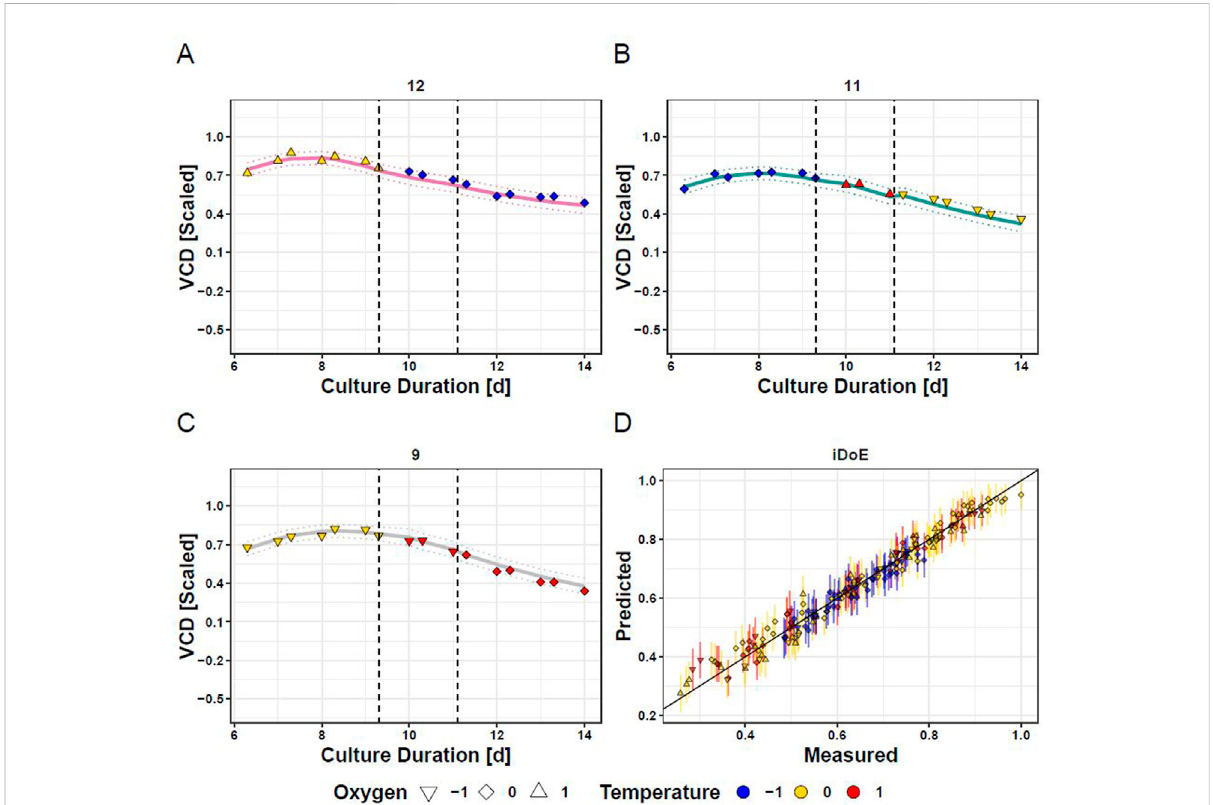
FIGURE 3 Fitting of Concatenated Model Predictions based on iDoE Data with VCD Measurements Obtained During the Conducted iDoE. Measured data points (colored symbols) are overlayed on mean predictions (solid lines) and the 95% prediction intervals (dashed lines) of the concatenated models of iDoE stage I and iDoE stage II joint with III for bioreactor 12 (A) , 11 (B) , and 9 (C) . Accuracy of concatenated predictions over scaled measured values (D)